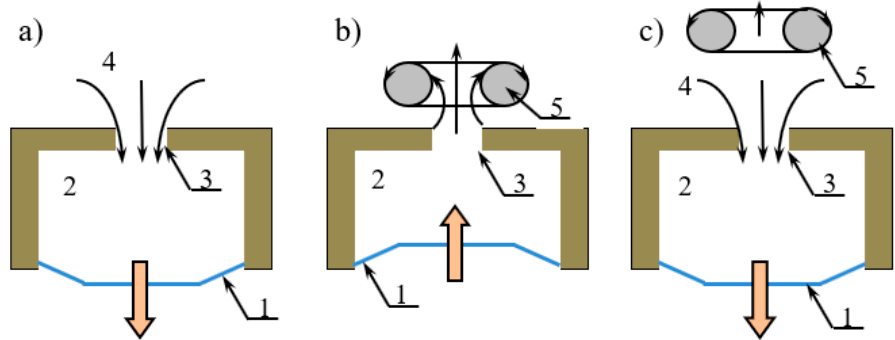
Figure 1. Generation of synthetic jet (SJ): ( a ) injection of fluid; ( b ) expulsion of fluid and SJ formation; ( c ) moving away of SJ and injection of a new volume of fluid to cavity (1—deformable diaphragm; 2—cavity; 3—orifice; 4—fluid injected to cavity; 5—synthetic jet).